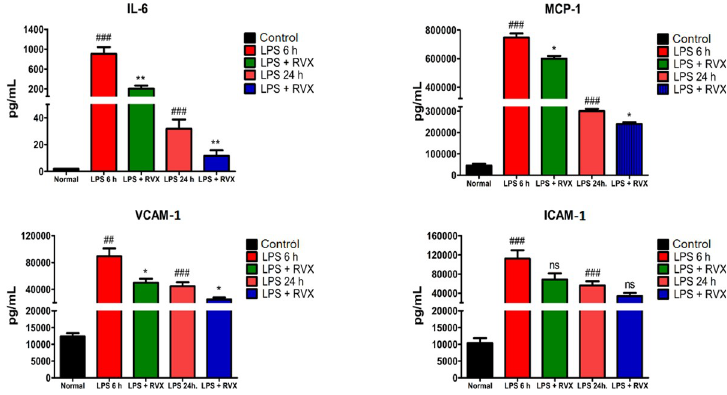
Fig 1. Role of RVX pre-treatment on LPS-induced proinflammatory and proadhesive mediator release in rat plasma. IL-6 (A), MCP-1 (1B), VCAM-1 (C) and ICAM-1 (D) plasma levels (pg/mL) from LPS treated rats in the presence or absence of RVX for 6 hours and 24 hours compared to controls. ##P < 0.01 and ###P < 0.001 (Student’s t- test) vs. control conditions. � P < 0.05, �� P < 0.01 and ��� P < 0.001 (Student’s t-test) vs LPS. Values are expressed as the mean ± SEM (n = 6).